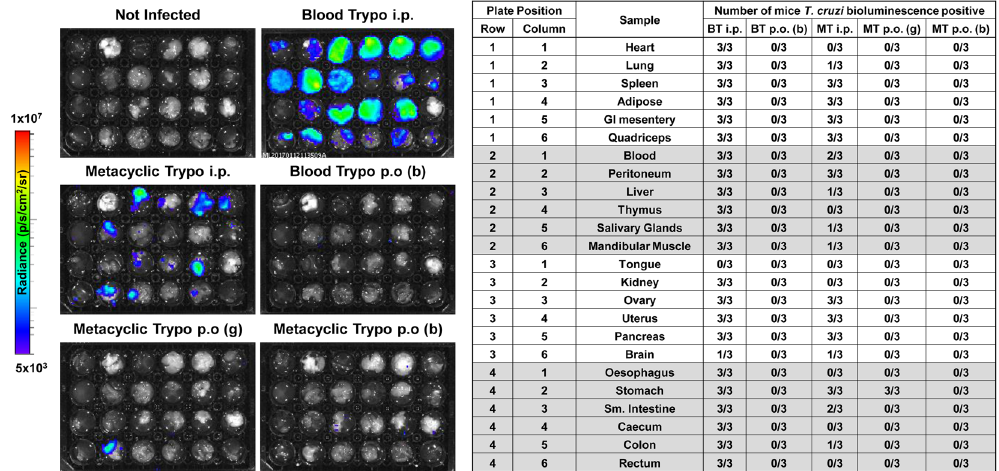
Figure 3. Ex vivo tissue bioluminescence imaging of mice acutely infected with T. cruzi after oral transmission. Mice were infected with 10 5 metacyclic or bloodstream T. cruzi trypomastigotes (MT, BT) by i.p. injection, oral gavage [p.o. (g)] into the stomach or deposition in the oral cavity [p.o. (b)]. Parasite distribution was assessed by bioluminescence signal in organs and tissue samples from mice at 6 days post-infection. Log-scale pseudocolour heat-maps show intensity of bioluminescence; minimum and maximum radiances are indicated. Samples were arranged as indicated in the table. Images are representative of three independent replicates with the table showing the overall assessment of T. cruzi presence vs. absence in each